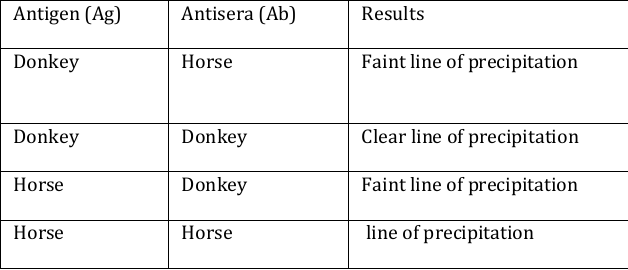
Table 2: Cross reactivity of antisera of horse and donkey meat